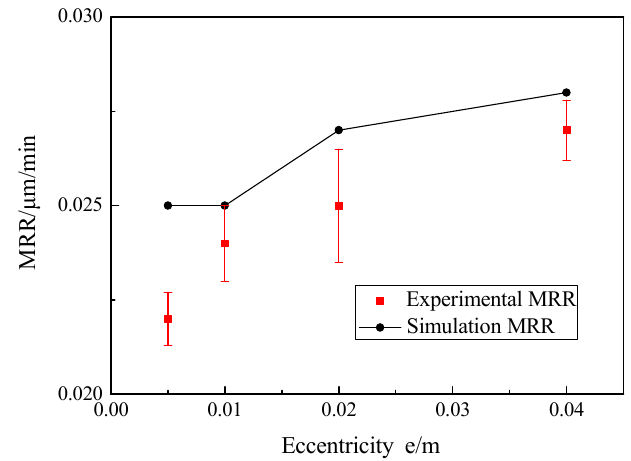
Figure 13. Effect of eccentricity on MRR.